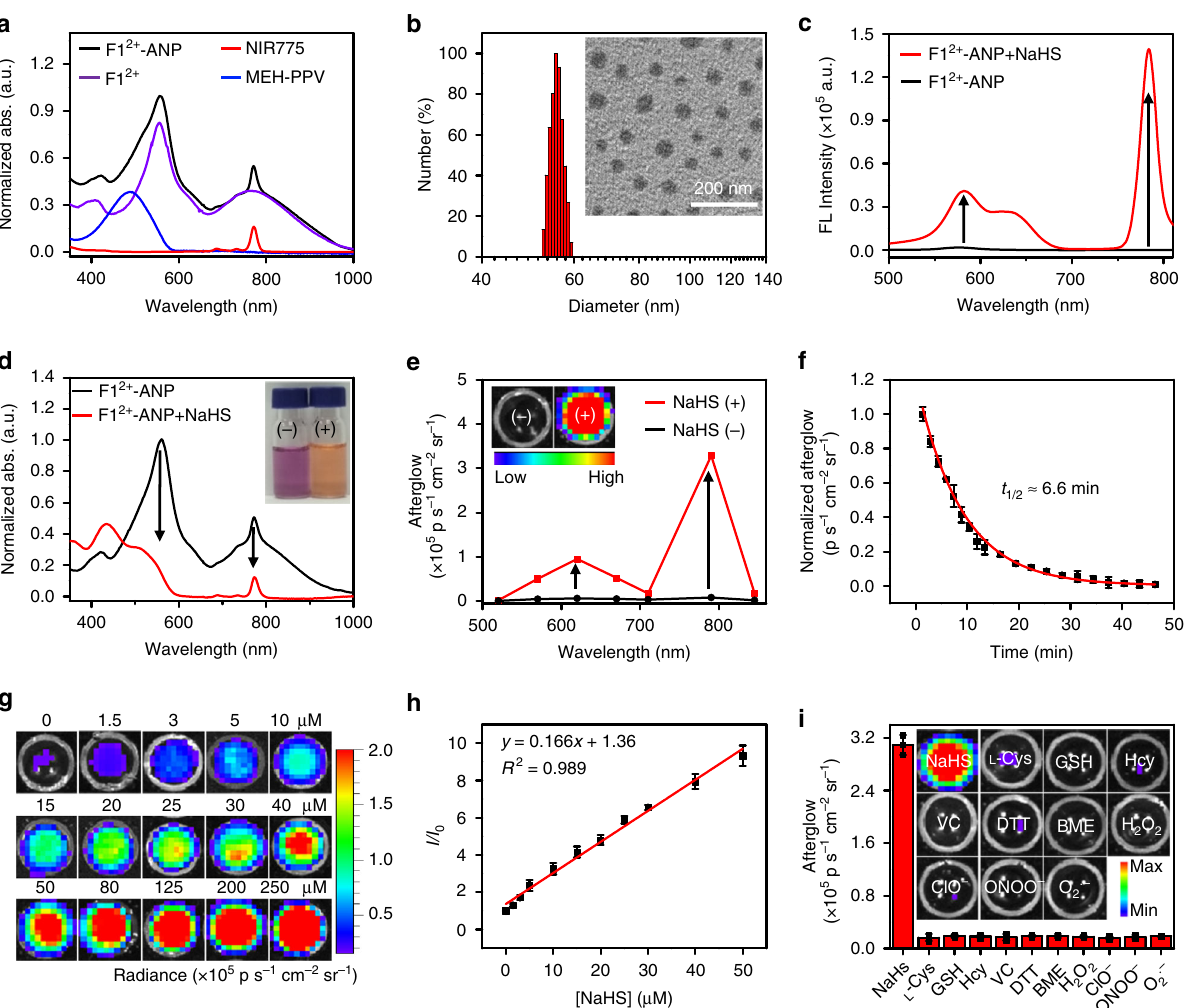
Fig. 2 Characterization of F1 2 + -ANP in vitro. a Comparison of the UV – visible-NIR absorption spectra of F1 2 + -ANP, F1 2 + , NIR775, and MEH-PPV. b DLS and transmission electron microscopy (TEM) image (inset) of F1 2 + -ANP. c Fluorescence and d absorption spectra of F1 2 + -ANP (58/28/2.2 μ g mL − 1 F1 2 + (BF 4 − ) 2 /MEH-PPV/NIR775) in the absence or presence of NaHS (200 μ M, 1 min). Inset: photographs of F1 2 + -ANP before ( − ) and after ( + ) incubation with NaHS in PBS buffer. Fluorescence spectra was acquired by synchronous fl uorescence scanning ( λ ex = 400 ‒ 800 nm, offset = 100 nm). e Afterglow luminescence spectra and images (inset) of F1 2 + -ANP (58/28/2.2 μ g mL − 1 F1 2 + (BF 4 − ) 2 /MEH-PPV/NIR775) with and without incubation with NaHS (200 μ M) in PBS buffer (pH 7.4) at 37 °C for 1 min, followed by irradiation with 808-nm laser (1 W cm − 2 , 1 min). After cessation of laser, the afterglow images were acquired under an open fi lter, with an acquisition time of 60 s. f Decay of afterglow luminescence of H 2 S-activated F1 2 + -ANP in PBS buffer at 37 °C. g Afterglow luminescence images of F1 2 + -ANP (58/28/2.2 μ g mL − 1 F1 2 + (BF 4 − ) 2 /MEH-PPV/NIR775) upon incubation with varying concentrations of NaHS (0, 1.5, 3, 5, 10, 15, 20, 25, 30, 40, 50, 80, 125, 200, and 250 μ M) at 37 °C for 1 min. h Plot of the afterglow luminescence intensity of F1 2 + -ANP and the concentration of NaHS from 0 to 50 μ M. i Afterglow luminescence intensities and images (inset) of F1 2 + -ANP upon incubation with different reductants or ROS (200 µ M NaHS, 1.25 mM L -cysteine ( L -Cys), 10 mM glutathione (GSH), 1 mM homocysteine (Hcy), 1.25 mM ascorbic acid (VC), 1.25 mM dithiothreitol (DTT), 100 μ M β -mercaptoethanol (BME), 1 mM H 2 O 2 , 1 mM ClO − , ONOO − (1 mM NaNO 2 + 1 mM H 2 O 2 ), O 2 . − (100 μ M xanthine + 22 mU xanthine oxidase)) for 10 min. The solutions were then irradiated with the 808-nm laser (1 W cm − 2 , 1 min), and the NIR afterglow images were collected for 60 s with a 790 nm fi lter after the end of irradiation. Data denote mean ± standard deviation (s.d.) ( n = 3). Source data are provided as a Source Data fi Fig. 5), unveiling characteristic absorption bands of MEH-PPV, indicate that F1 2 + was a more ef fi cient H 2 S-responsive chro- NIR775, and F1 2 + (Fig. 2a). Dynamic light scattering (DLS) mophore than 1 2 + . and transmission electron microscopy analysis revealed that F1 2 + -ANP appeared as mono-disperse nanoparticles, with a mean hydrodynamic size of ~55 nm (Fig. 2b). As expected, the fl uorescence of MEH-PPV (580 nm) and NIR775 (780 nm) within F1 2 + -ANP was ef fi ciently quenched by F1 2 + owing to extensive spectral overlaps between their fl uorescence emissions and F1 2 + absorption (Fig. 2c). Fluorescence lifetime measure- ment revealed that the lifetimes of MEH-PPV and NIR775 within ANP was optimized at ~28/2.2/58 (by mass) (Supplementary